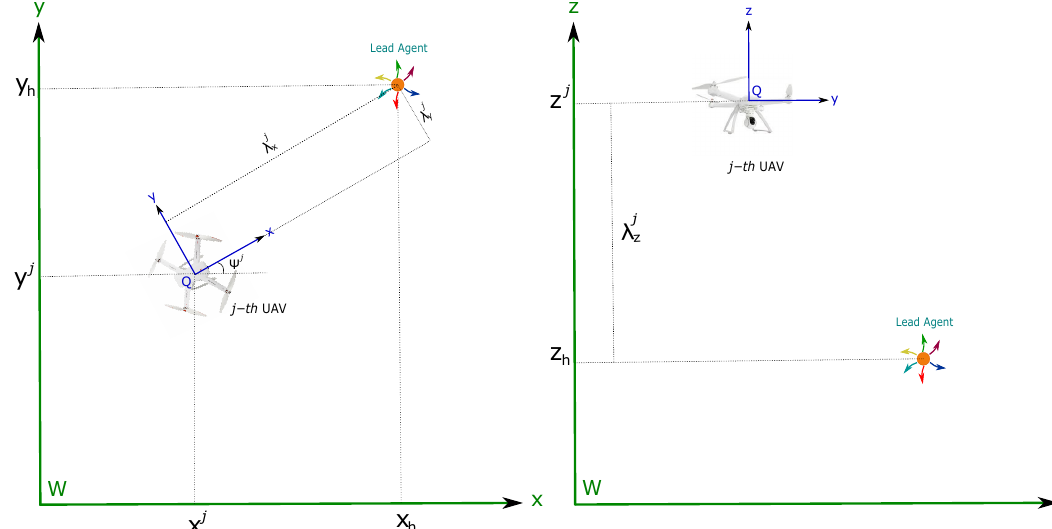
Figure 6. UAVs-lead agent flight